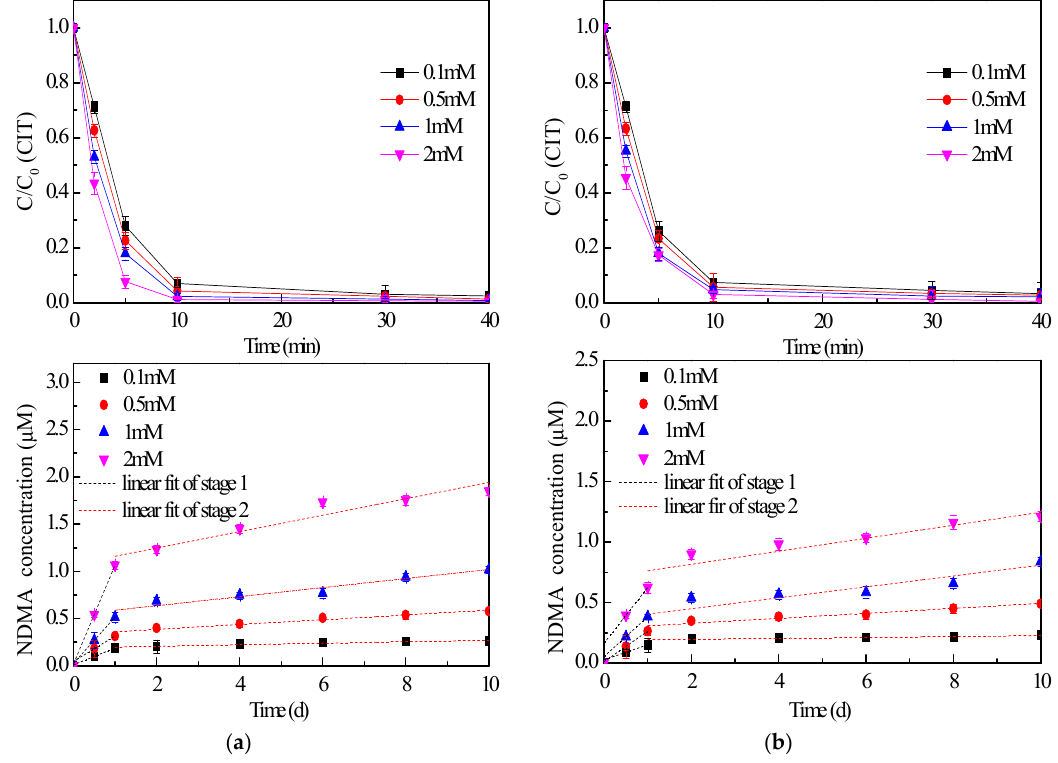
Figure 2. Effect of disinfectant dose on CIT removal and NDMA formation (NaOCl ( a ), ClO 2 ( b ), C 0 = 20 µ M, pH = 7.0) (Black dash lines represent linear fit of the first stage of NDMA generation, red dash lines represent linear fit of the second stage of NDMA generation).